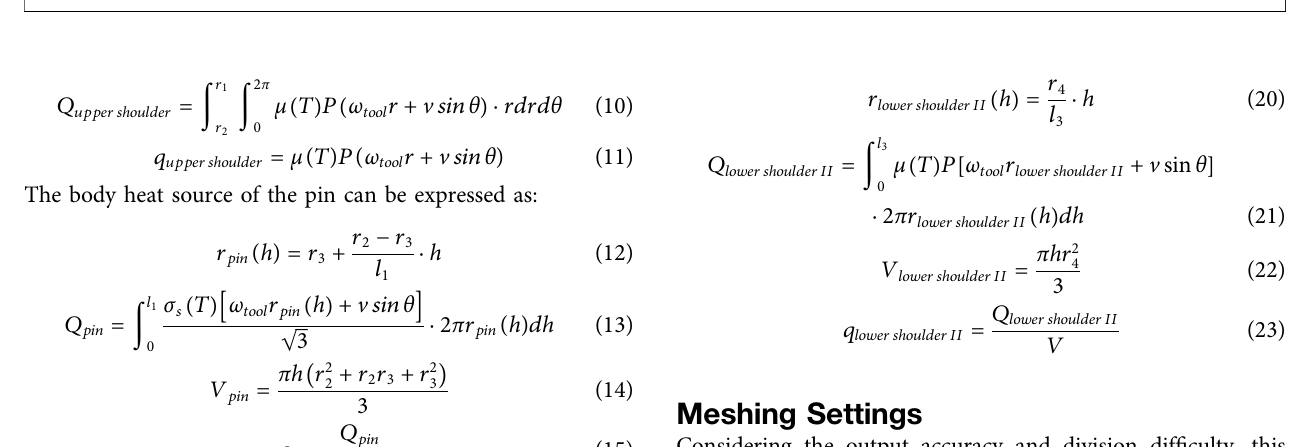
FIGURE 5 | Contour of temperature distribution at different time in the longitudinal section of the workpiece (unit: ° C): (A) time (cid:1) 10 s, (B) time (cid:1) 20 s, (C) time (cid:1) 30 s, (D) time (cid:1) 40 s, (E) time (cid:1) 50 s.